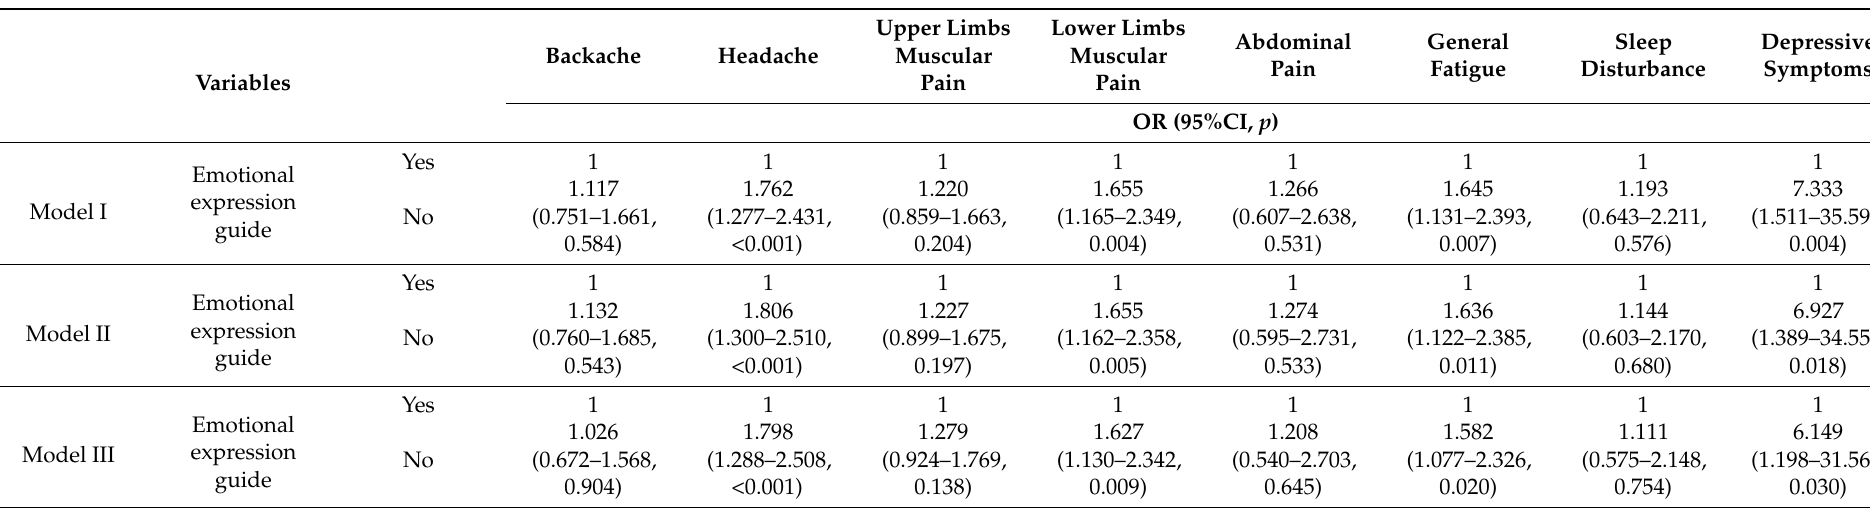
Backache Headache